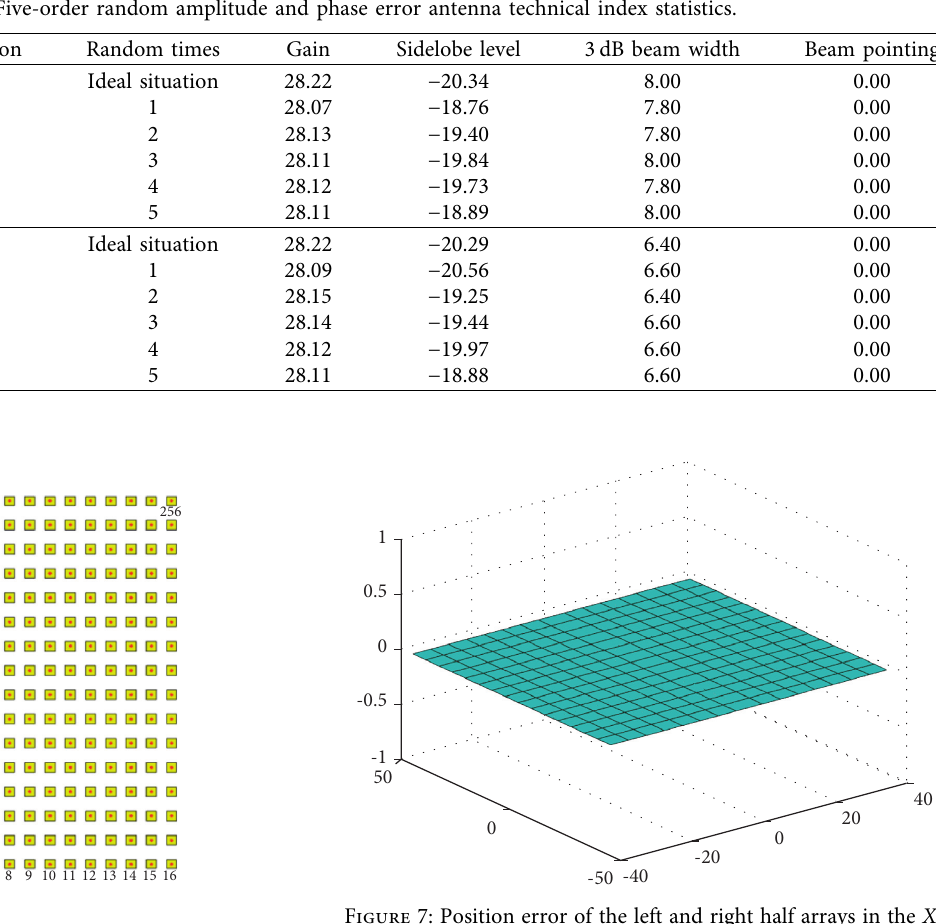
Figure 6: Schematic diagram of a millimeter-wave antenna array.